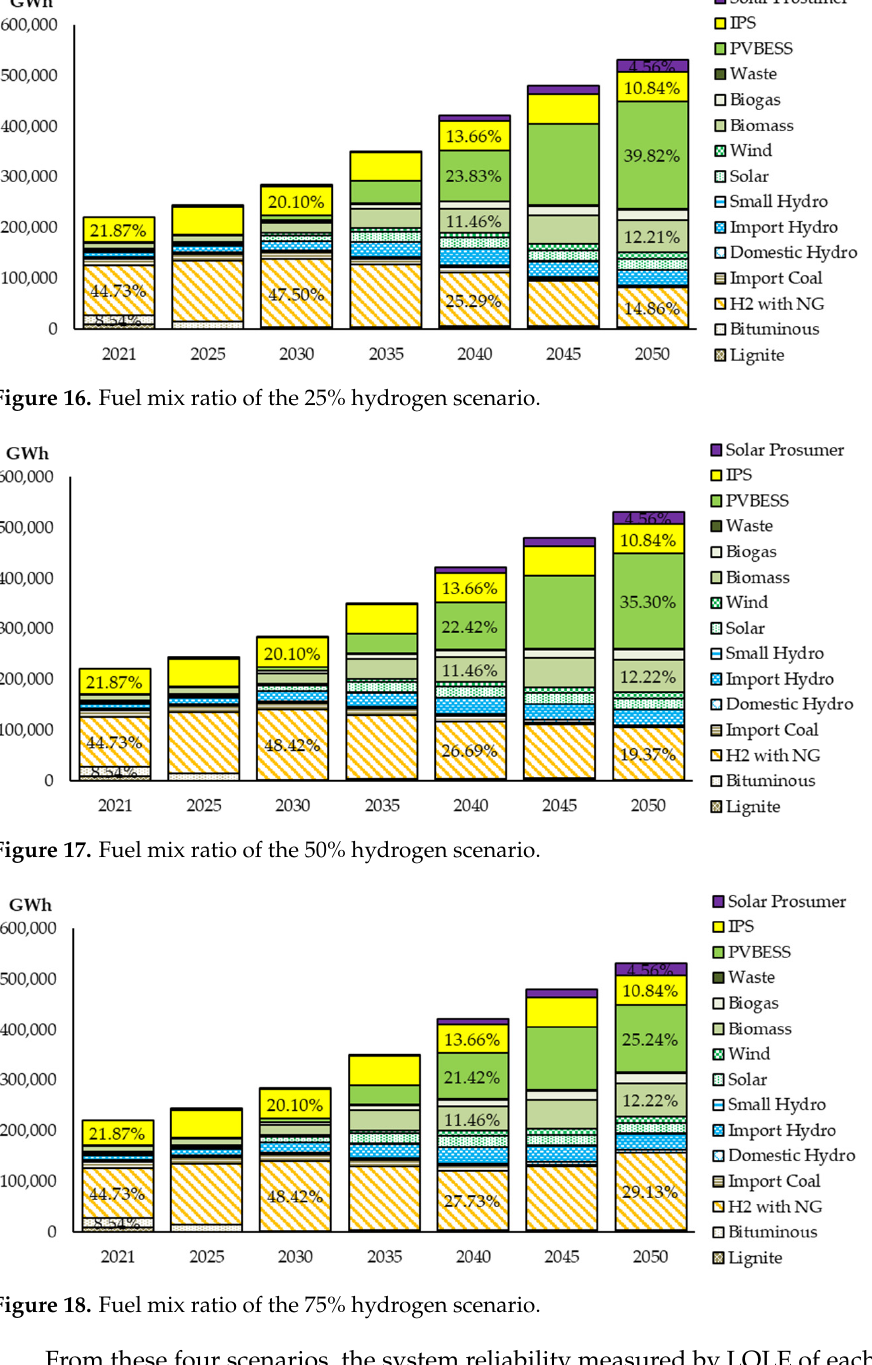
Figure 15. Fuel mix ratio of the 0% hydrogen scenario.